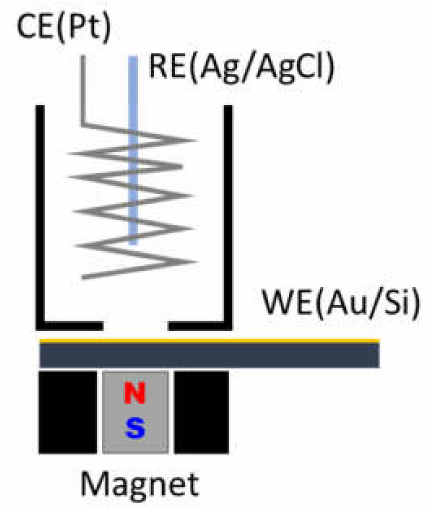
Figure 1. Schematic view of the experimental